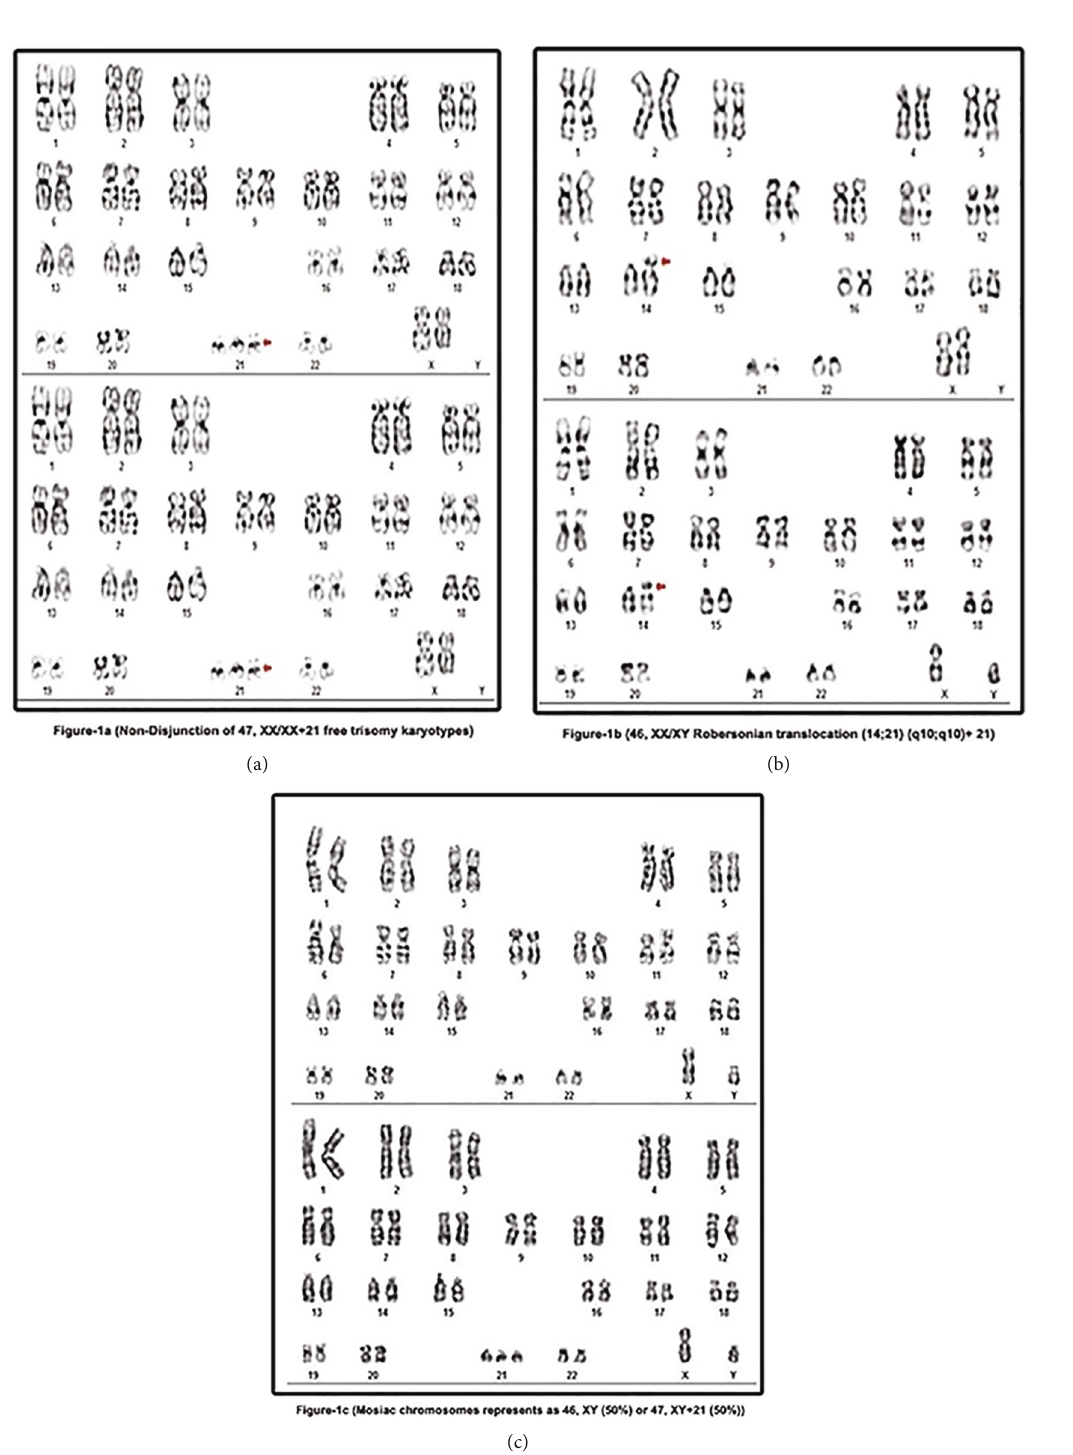
Figure 1: Representation of (a) free trisomy 21, (b) Robertsonian translocated DS, and (c) mosaic DS with 46/47+21 XX and XY